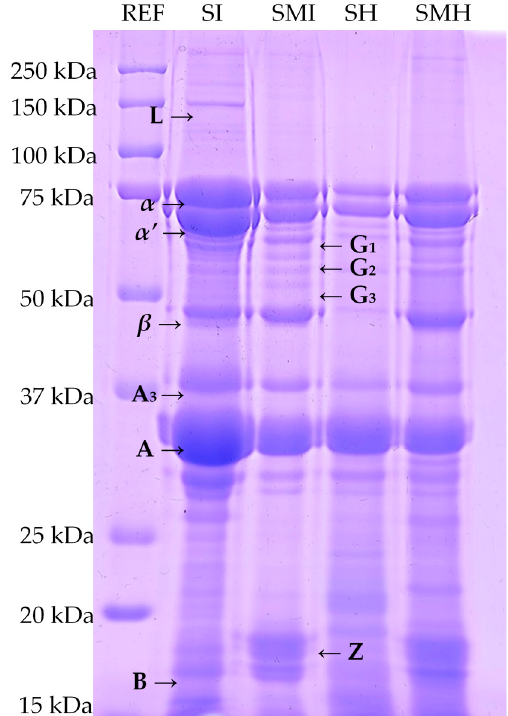
Figure 3. Electrophoretic profile of isolates and hydrolysates of soybean-maize and soybean proteins (SDS-PAGE). Reference (REF); soybean isolate (SI); soybean-maize isolate (SMI); soybean hydrolysate (SH); soybean-maize hydrolysate (SMH). A typical electrophoretic pattern for soybean protein: L : lipoxygenase; α , α′ and β subunits of β - conglycinin; A 3 : acidic glycinin subunit; A : acidic glycinin subunits (A 1a , A 1b , A 2 , A 4 ); B : basic glycinin subunit; G 1-3 : globulins from maize germ; Z : zein.3.4. Amino Acid Composition.